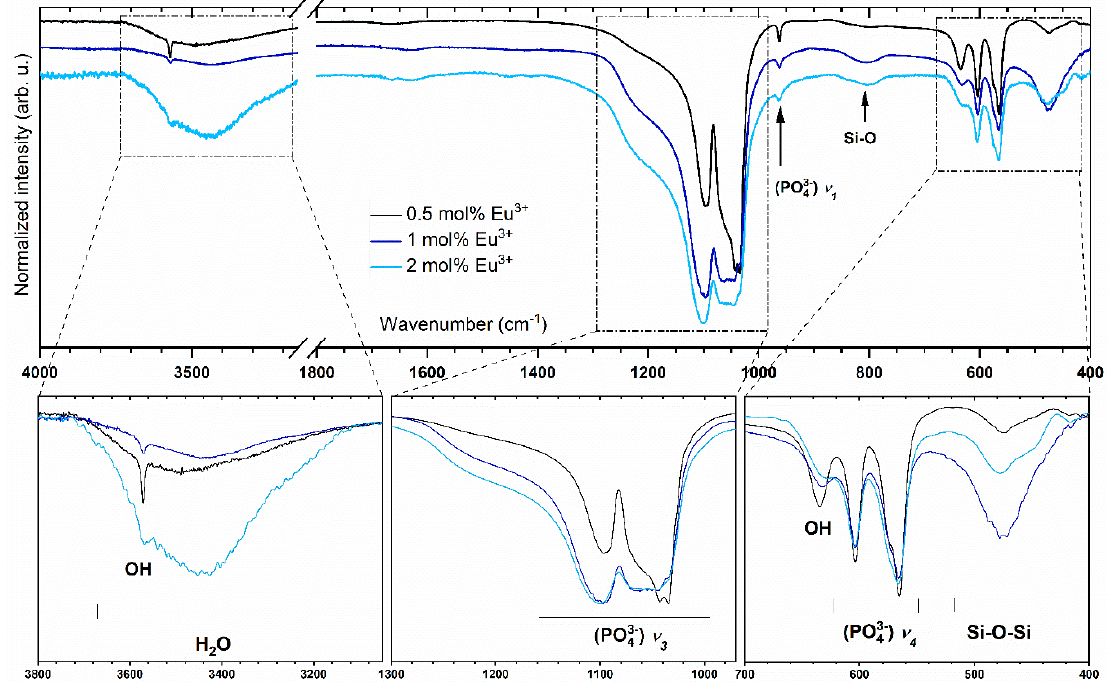
Figure 2. FT-IR spectra of the silicate-substituted hydroxyapatite co-doped with Sr 2+ (2.0 mol%) and Eu 3+ (0.5, 1.0 and 2.0 mol%)